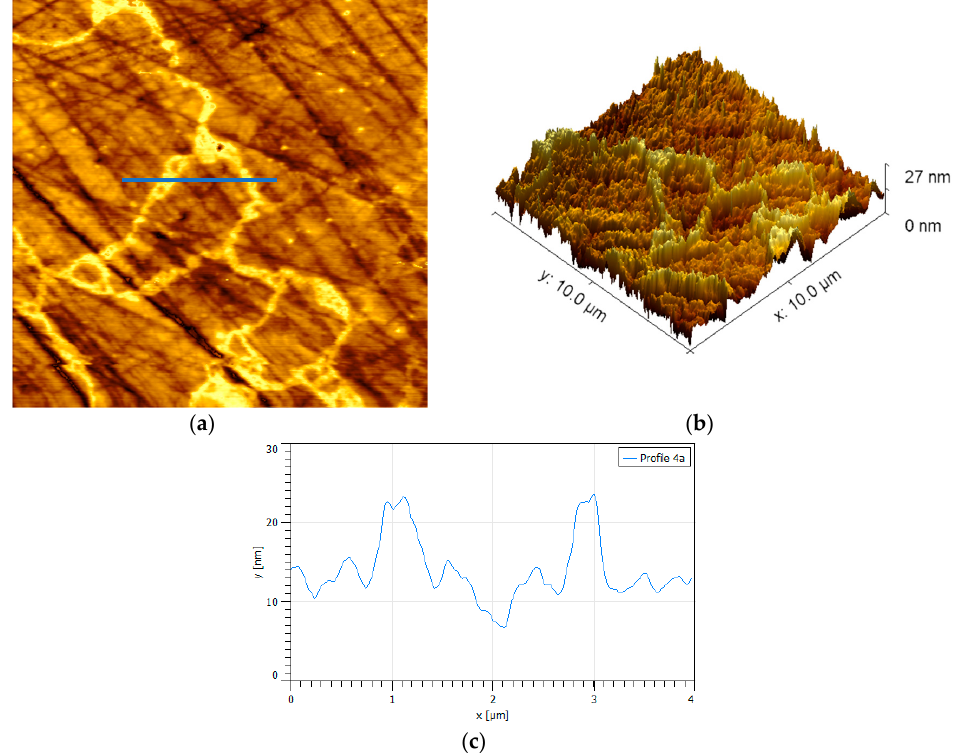
Figure 3. Surface {100} of polished pyrite exposed to hydrogen peroxide for 300 s. ( a ) Percolation oxide-connected clusters and a few tiny small oxide islands, scan size is 4 × 4 μ m 2 . ( b ) Topographic map. ( c ) Height profile corresponding to the blue line in ( a ); highest peaks correspond to oxide pillars. When the samples of oxidized pyrite came into contact with a PAX solution at 10 − 3 M, the results